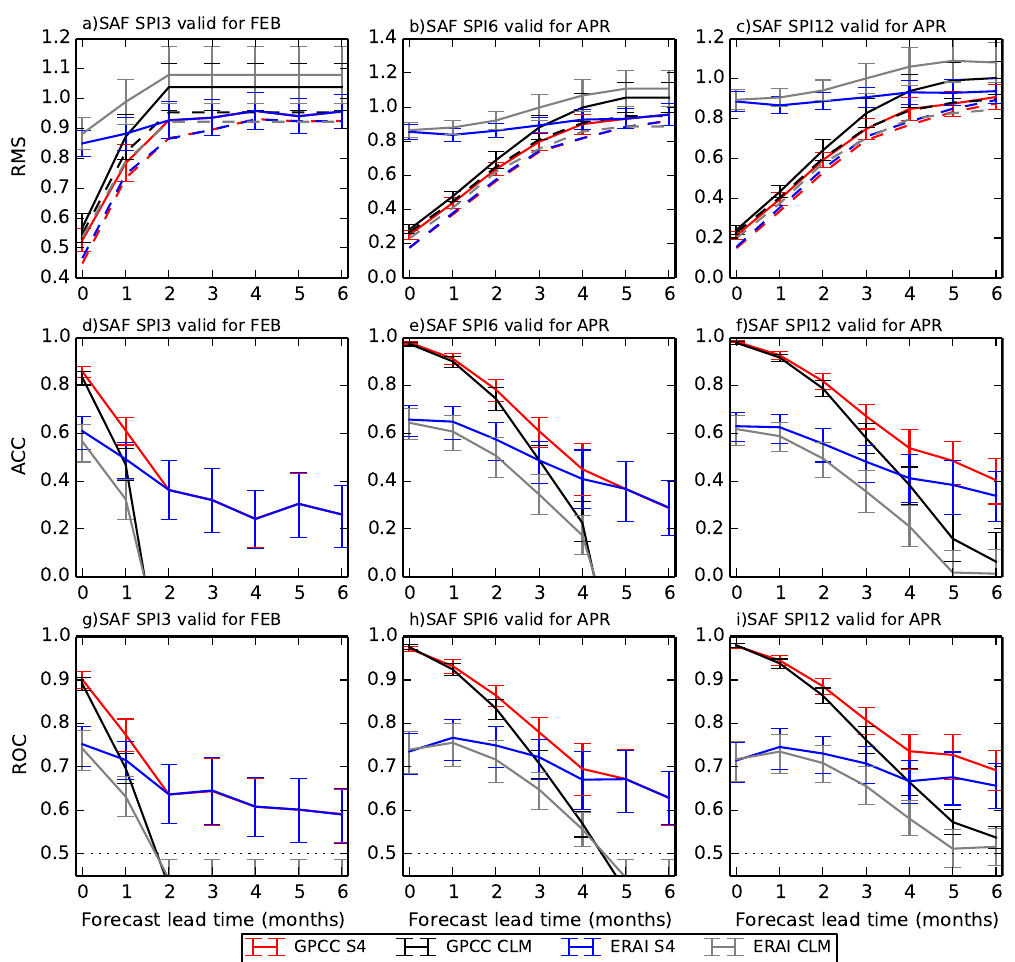
Figure 1. Seasonal forecast evaluation resume for the South Africa region (SAF) for the SPI-3 (a, d, g) , SPI-6 (b, e, h) , and SPI-12 (c, f, i) . For each SPI timescale the evaluation consist of three panels displaying a specific score as a function of lead time (horizontal axis) for a specific verification date (in the title) for the GPCC S4 forecasts (red), GPCC CLM (black), ERAI S4 (blue) and ERAI CLM (grey). (a–c) rms error of the ensemble mean and ensemble spread about the ensemble mean in dashed; (d–f) anomaly correlation coefficient; (g–i) area under the ROC curve for SPI forecasts below − 0.8. The error bars in all panels denote the 95% confidence intervals computed from 1000-sample bootstrapping with